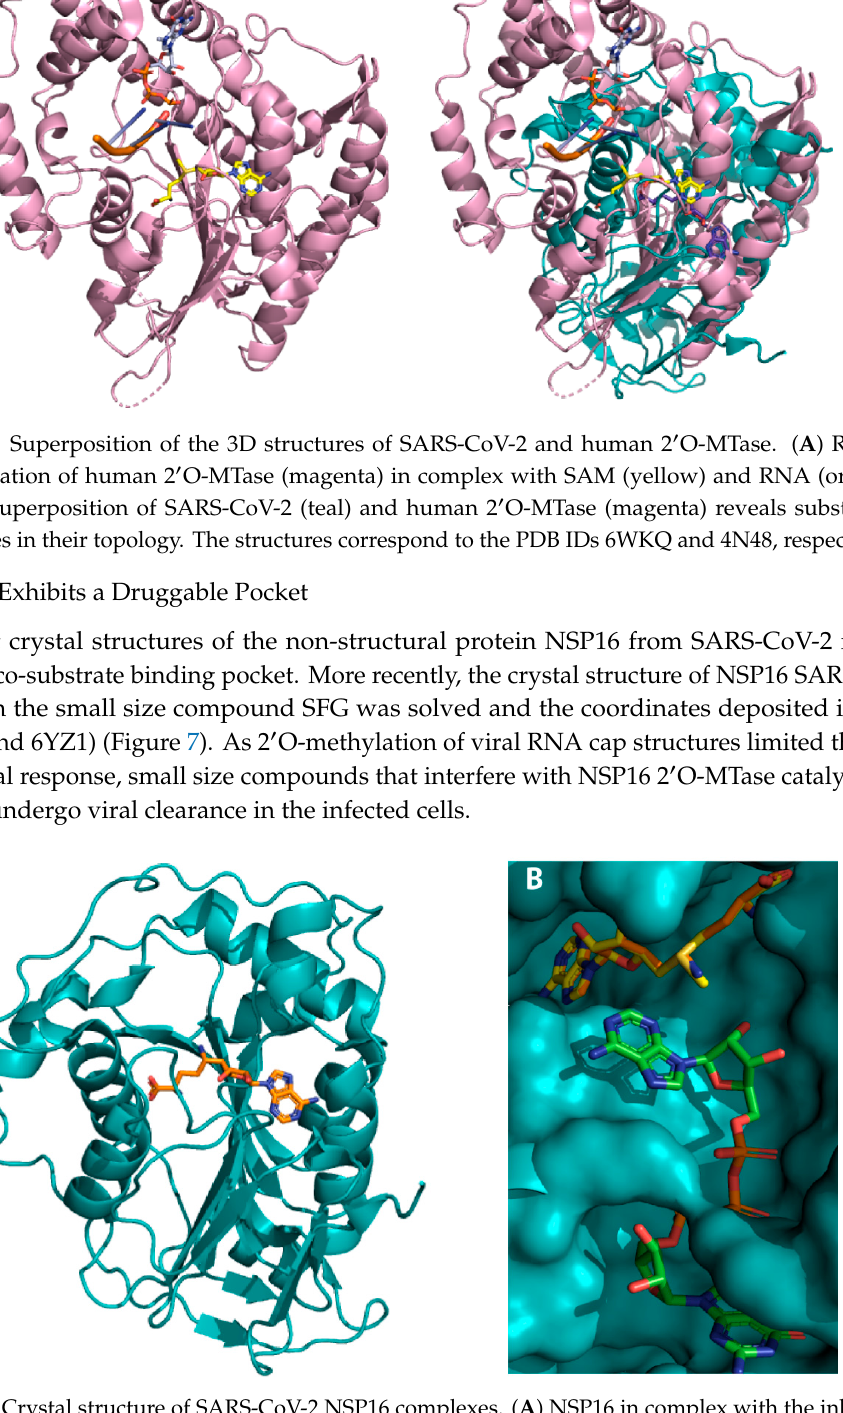
Figure 7. Crystal structure of SARS-CoV-2 NSP16 complexes. ( A ) NSP16 in complex with the inhibitor SFG. The inhibitor (shown in orange) binds to the same region as SAM (PDB ID 6WKQ). ( B ) Structure superposition of SARS-CoV-2 NSP16 in complex with SAM (yellow) and RNA (green) (PDB ID 6WVN) with that of NSP16 in complex with SFG, a SAM analogue in which an amino group substitutes the sulphur atom of the former. The structure superposition shows that SAM and SFG bind to the same NSP16 pocket and that RNA binding implicates a region proximal to the SAM binding